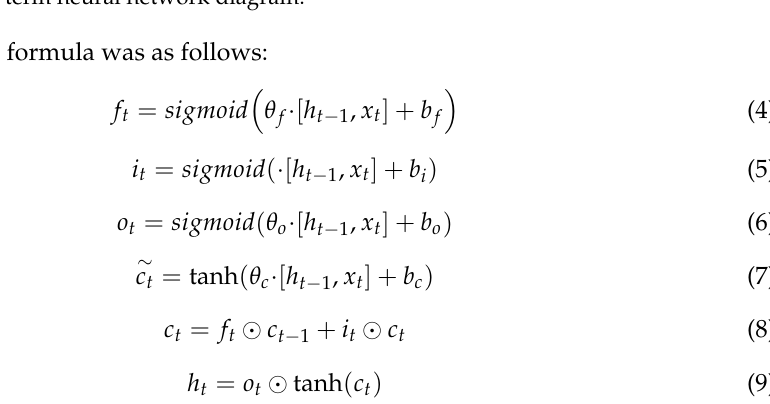
Figure 2. Long short-term neural network diagram.